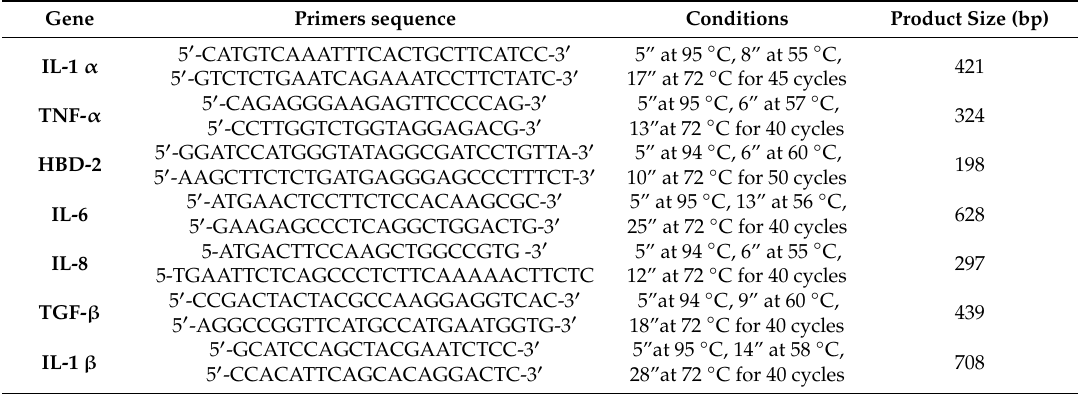
Gene, primers sequences and conditions regarding the expression of the proinflammatory